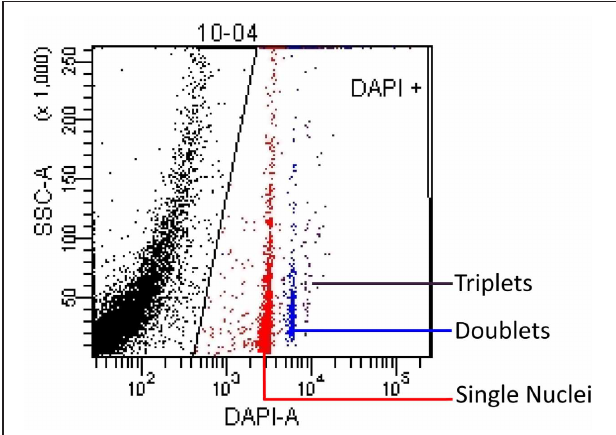
known volume of sample. The black area on the left edge of the plot contains debris that is excluded by the nuclei gate.